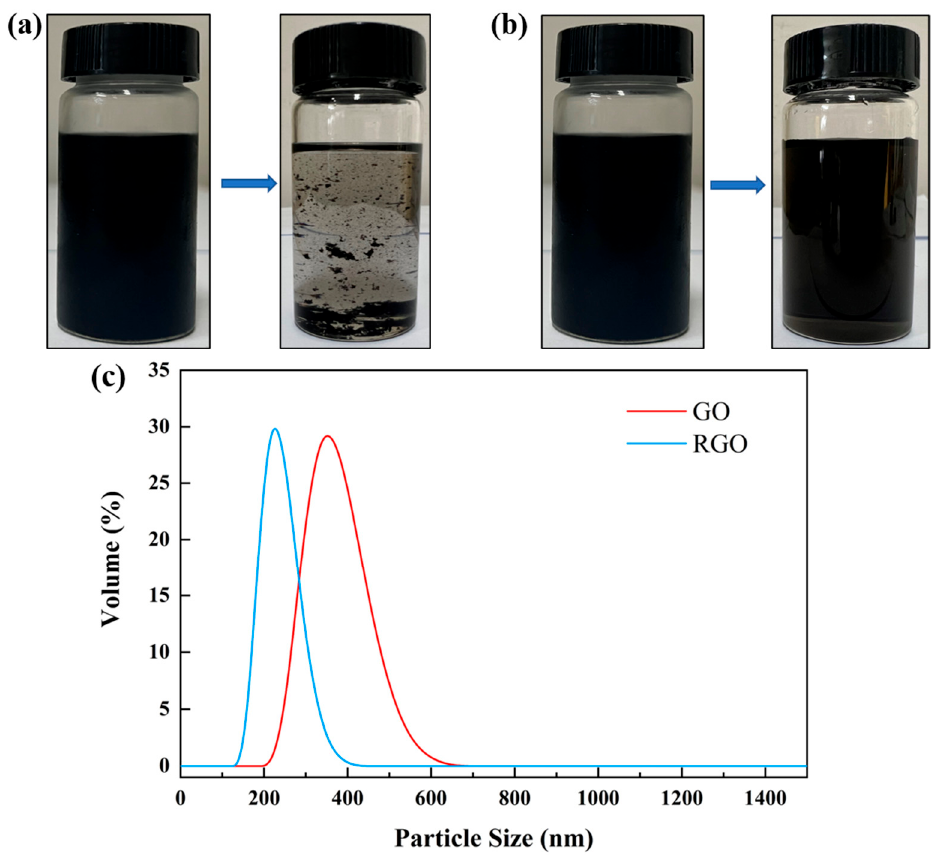
Figure 1. NMP dispersion of RGO before and after one month: ( a ) RGO EGM , ( b ) RGO NMP , and ( c ) redisperse RGO.